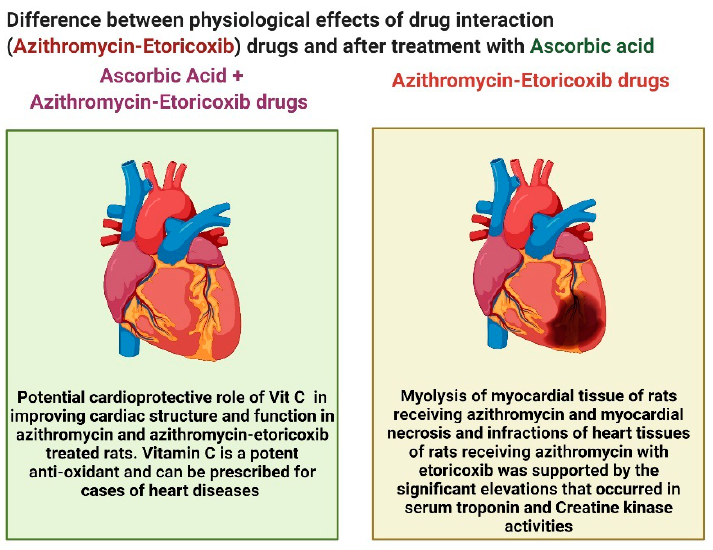
Figure 4. Comparison between drug interactions (azithromycin and etoricoxib) and after ascorbic acid.